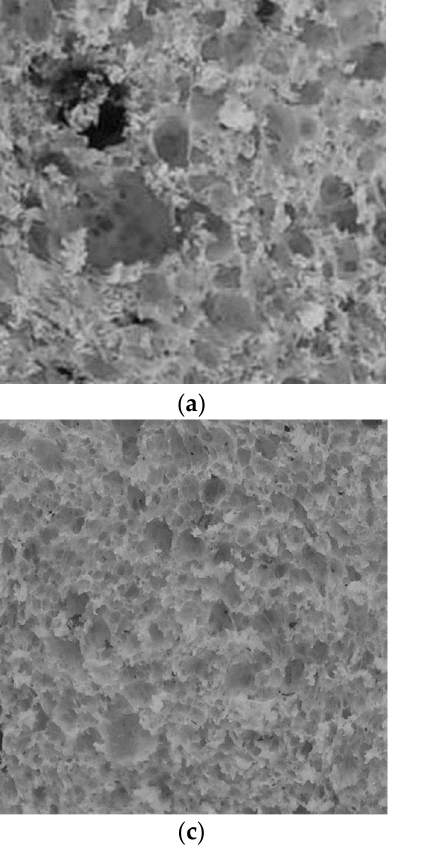
Figure 1. Images of the porous structure of the crumb of the panettone samples (area 60 × 60 mm): ( a )PC, ( b ) PB, ( c ) PMM and ( d ) PE. ( a )PC, ( b ) PB, ( c ) PMM and ( d ) PE. The image is taken at a 10 × zoom expressed on a scale of 1